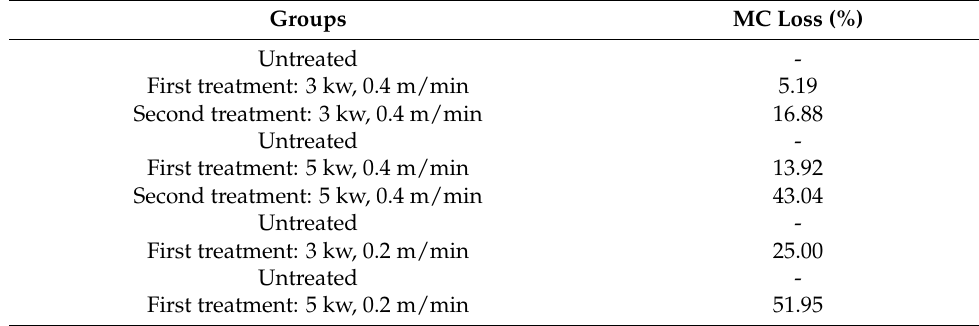
Table 2. Reduction in moisture content compared to untreated groups found by [45]. Groups MC Loss (%) Untreated - First treatment: 3 kw, 0.4 m/min 5.19 Second treatment: 3 kw, 0.4 m/min 16.88 Untreated - First treatment: 5 kw, 0.4 m/min 13.92 Second treatment: 5 kw, 0.4 m/min 43.04 Untreated - First treatment: 3 kw, 0.2 m/min 25.00 Untreated - First treatment: 5 kw, 0.2 m/min